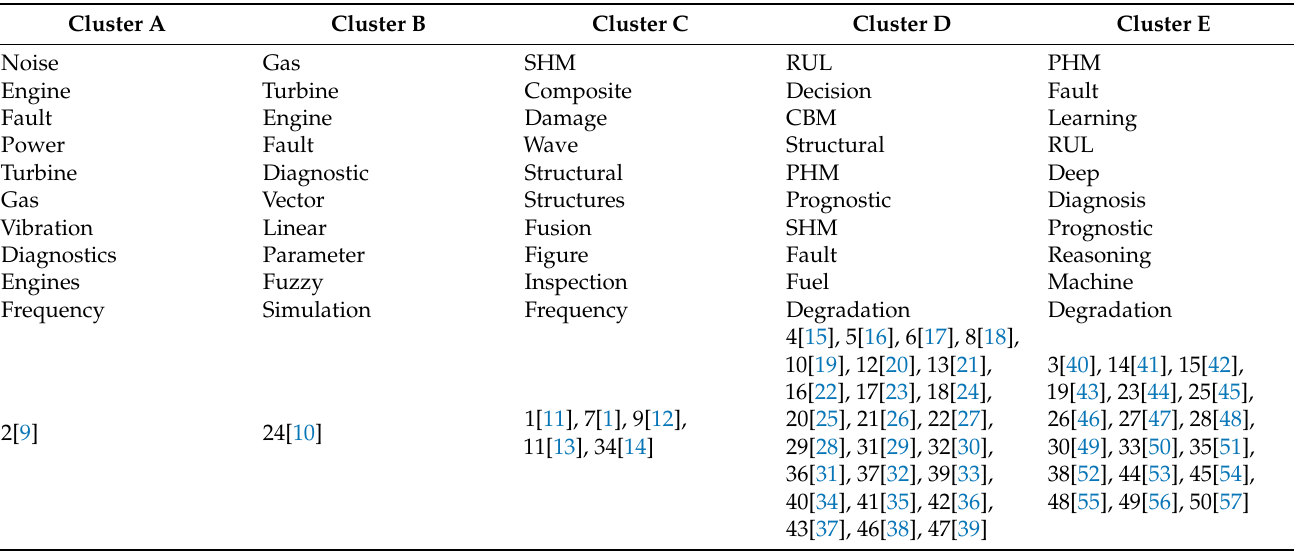
Table 3. Top ten terms of fifty review papers using TF-IDF and K-means clustering, with reference to corresponding numbers from Figure 4 and supporting references to papers in brackets